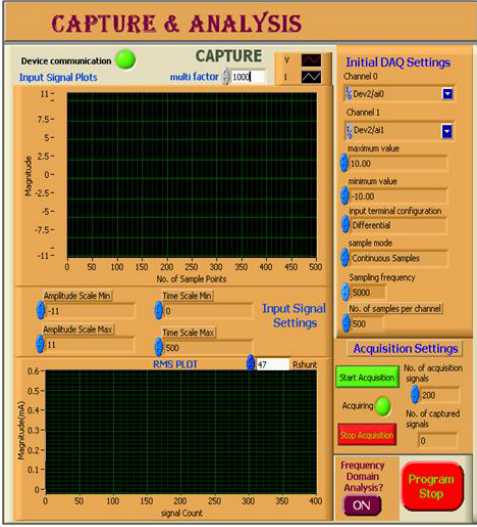
Figure 17. LabVIEW output Voltage imprisons in the front panel and analysis of multilevel inverter.